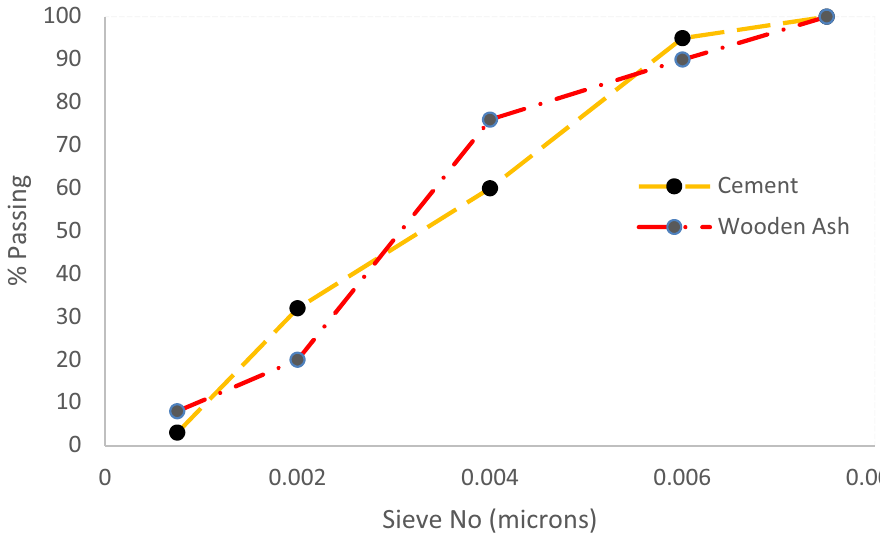
Figure 1. Gradation curve of cement and wooden ash.